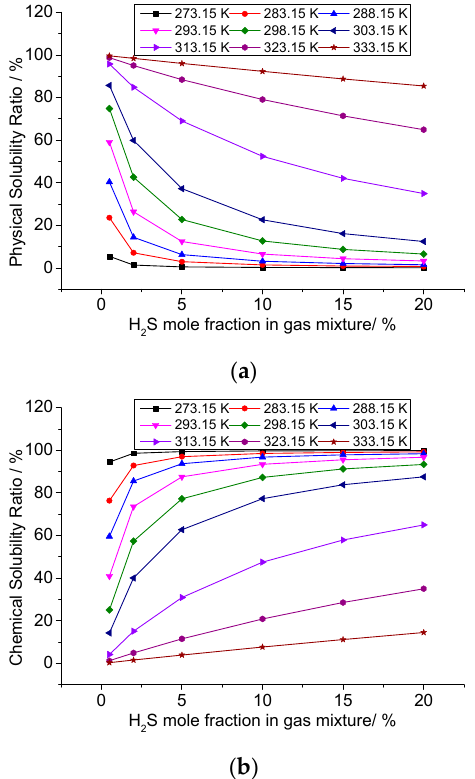
Figure 15. Percentage change curves of physical and chemical solubility. ( a ) 6.0 MPa physical solu- bility; ( b ) 6.0 MPa chemical solubility. In Figure 16, the short, dashed line represents the percentage of chemical solubility of elemental sulfur and the solid line with the same color as the dashed line represents the percentage of physical solubility of elemental sulfur. Overall, the larger the molar fraction of H 2 S in the gas, the higher the percentage of chemical solubility. However, the increase in the percentage of chemical solubility was also limited by the temperature. As shown in Figure 16, when the temperature was greater than 323.15 K, the percentage of chemical solubility was still less than 50%, even though the molar fraction of H 2 S gradually in- creased from 0% to 20%. This was because the tendency of the increase in temperature to promote the physical solution mechanism still dominated.